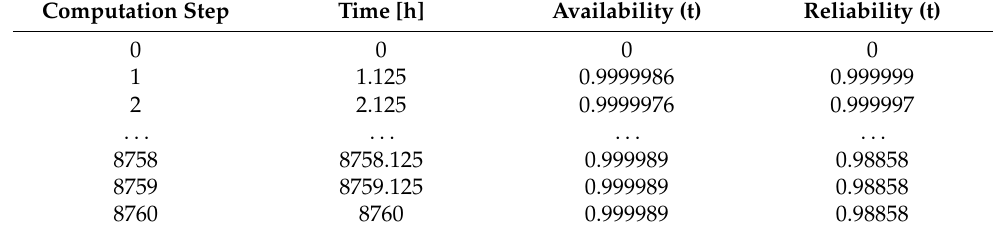
Table 1. Calculations of the FAS availability and reliability coefficients for the S 0 state.